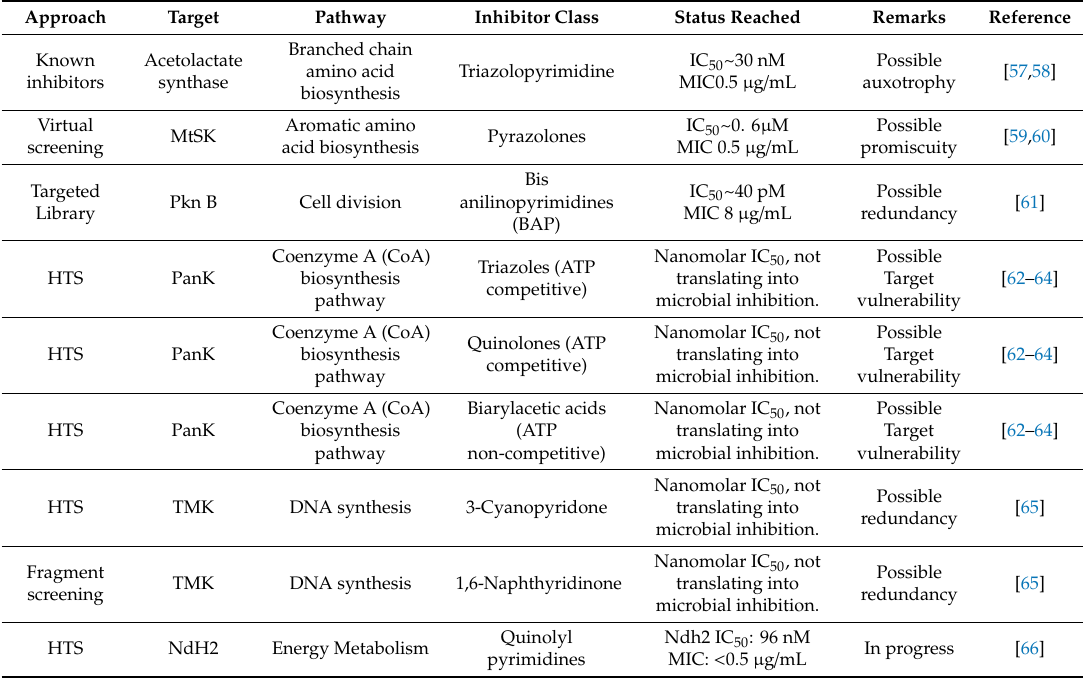
Table 2. Target-based e ff orts at